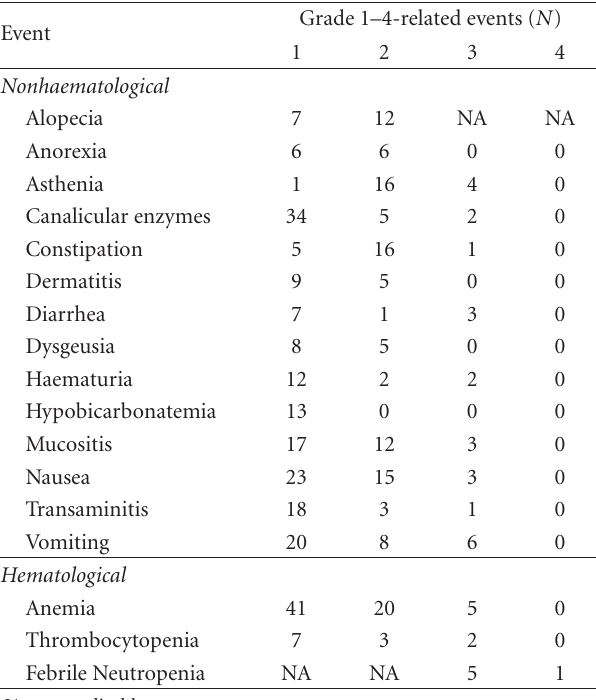
Table 1: Patient characteristics. Table 2: Adverse events occurring in more than 10